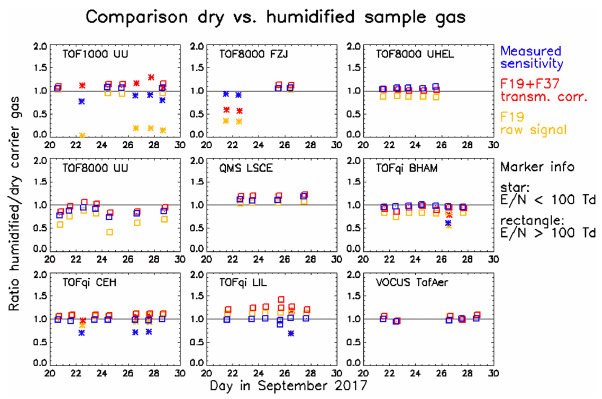
Figure 8. Comparison of gas standard injections using humidified and dry carrier gas. The ratios obtained for humidified versus dry injections are shown for (i) the mean measured sensitivity of a core set of compounds (blue), (ii) the transmission-corrected primary ion signal (red), and (iii) the raw H 3 O + signal (yellow). The symbols separate measurements done at E/N levels above (rectangles) or below (stars)